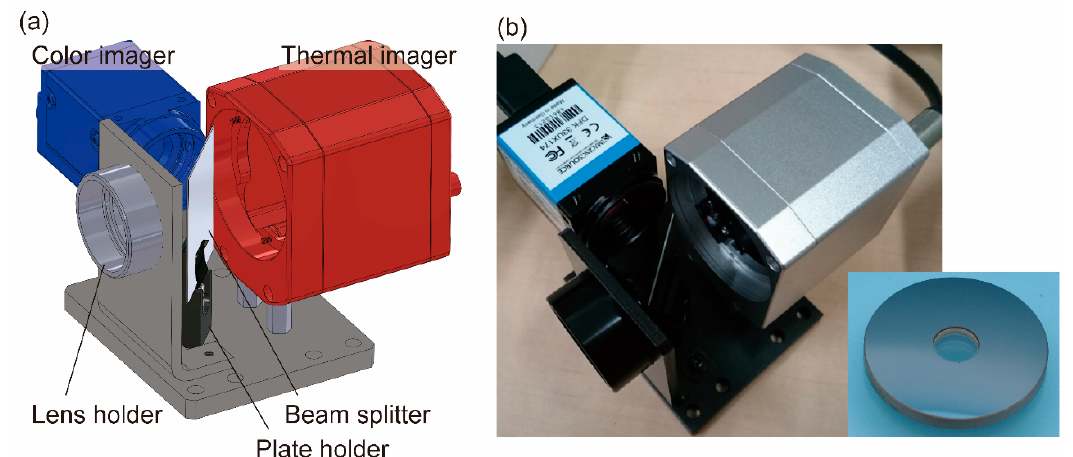
Figure 4. Design and implementation of a coaxial imaging system. A lens holder, plate holder, and thermal and color imagers were fixed on the same plate. A silicon beam splitter was placed in the plate holder. ( a ) Perspective view drawn with 3D CAD software (version 2017, SolidWorks, Dassault Systèmes SolidWorks Corporation, Waltham, MA, U.S.A). ( b ) Photographs of the implemented system and silicon–glass hybrid lens.